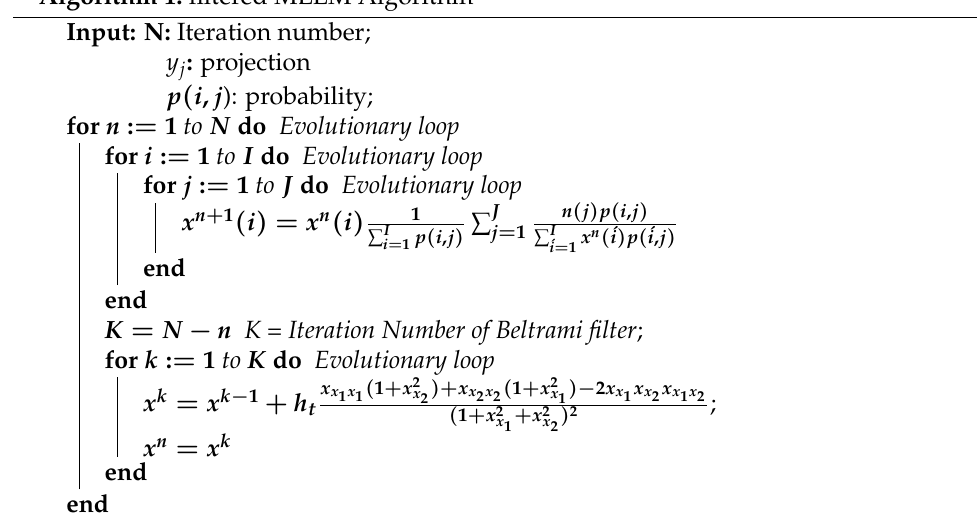
Algorithm 1: filtered MLEM